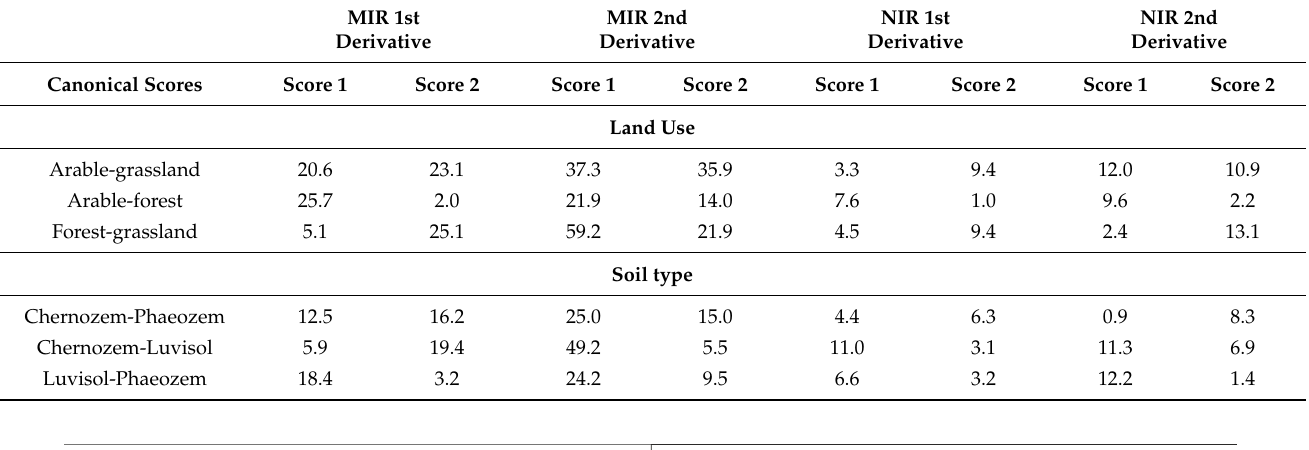
Table 1. Mahalanobis distance for various variants of the CVA analysis.